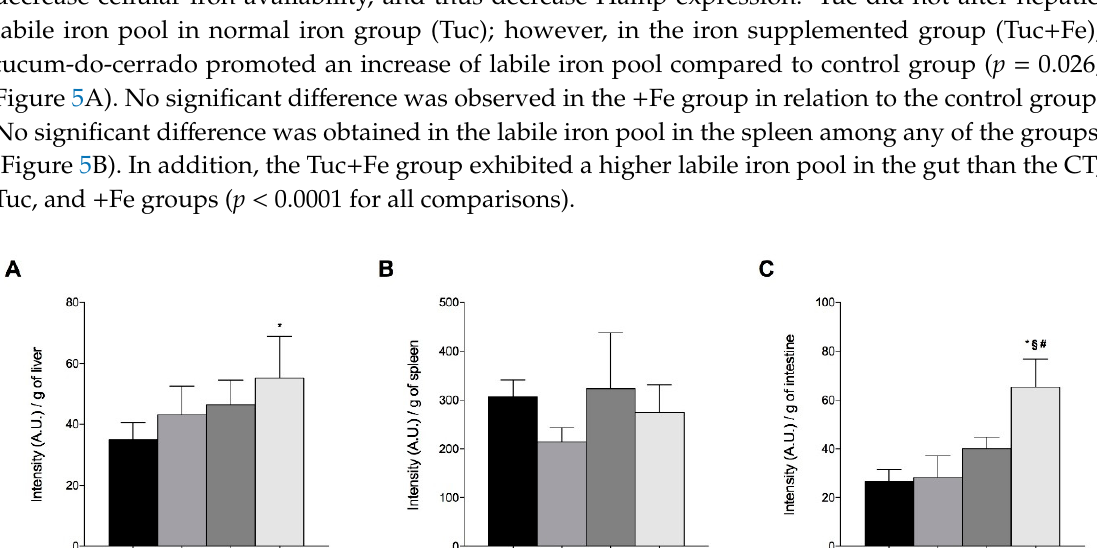
Figure 4. Hepatic pSTAT3 protein levels in liver of rats fed control diet, tucum-do-cerrado (Tuc), iron-enriched diet ( + Fe), or tucum-do-cerrado iron-enriched diet (Tuc + Fe), for 12 weeks. Data are the average ± standard deviation ( n = 6). Statistical differences compared to: * CT group; # Tuc group, and § +Fe group and ( p < 0.05).